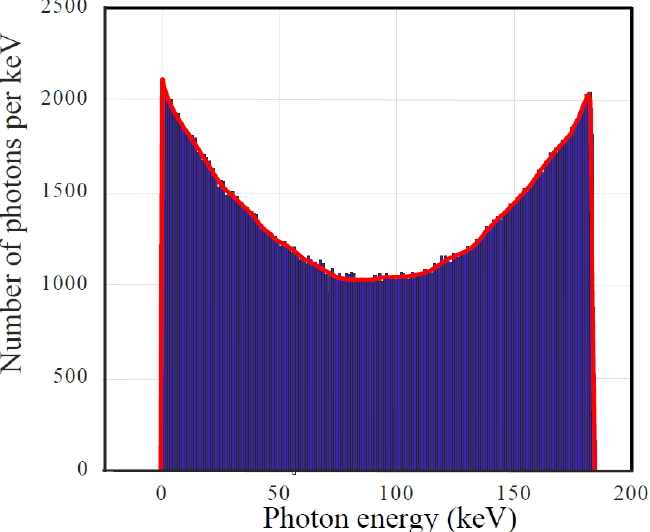
Figure 10. Spectrum of uncollimated scattered photons for the high energy case with electron energy E e = 100 MeV.